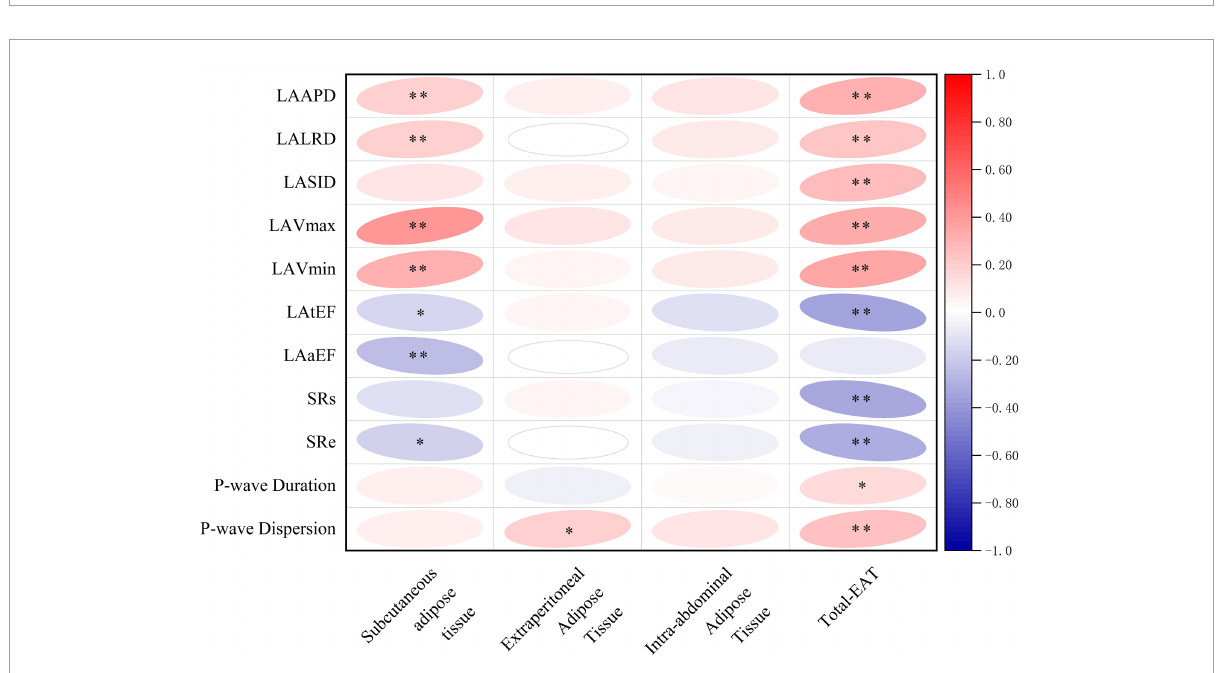
FIGURE4 Correlations of different adipose tissues with LA remodeling and dysfunction in AF patients. ∗ P < 0.05, ∗∗ P < 0.01. EAT, epicardial adipose tissue; Total-EAT, mean EAT thickness surrounding the whole heart; LAAPD, LA anteroposterior diameter; LALRD, LA left and right diameter; LASID, superior and inferior diameter of left atrium; LAVmax, LA maximum volume; LAVmin, LA minimum volume; LAtEF, LA total emptying fraction; LAaEF, LA active ejection fraction; SRs, strain rate during ventricular systole; SRe, strain rate during early ventricular